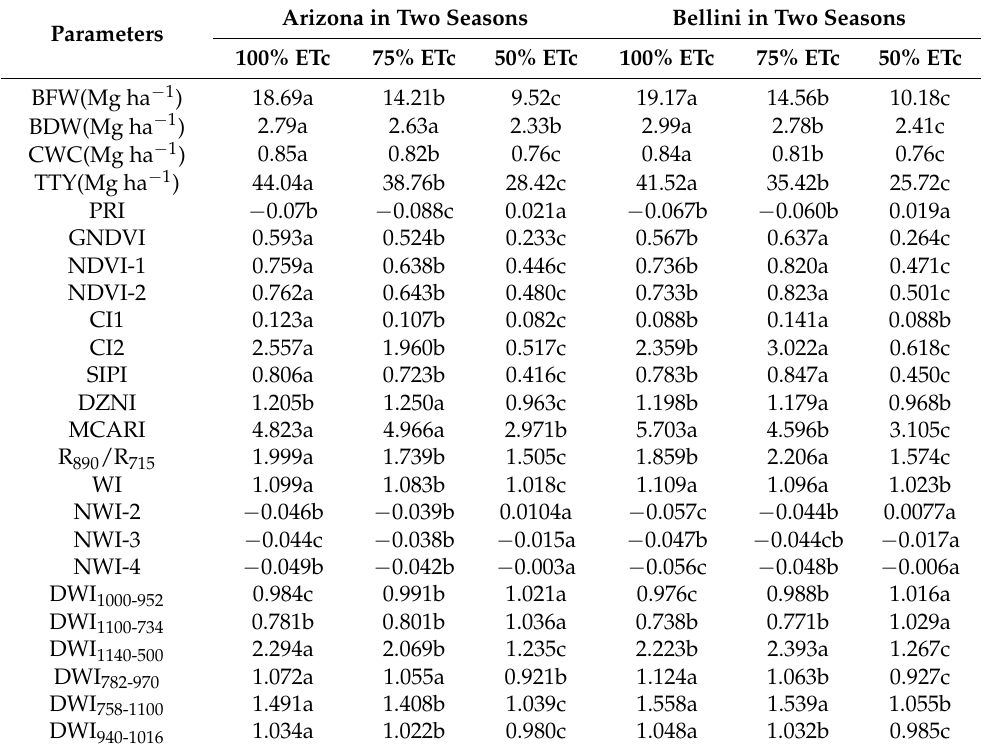
Table 3. Comparison of mean values of biomass fresh weight (BFW) biomass dry weight (BDW), canopy water content (CWC), total tuber yield (TTY), and twenty spectral reflectance indices (SRIs) of potato crops under three irrigation regimes for each potato variety across two